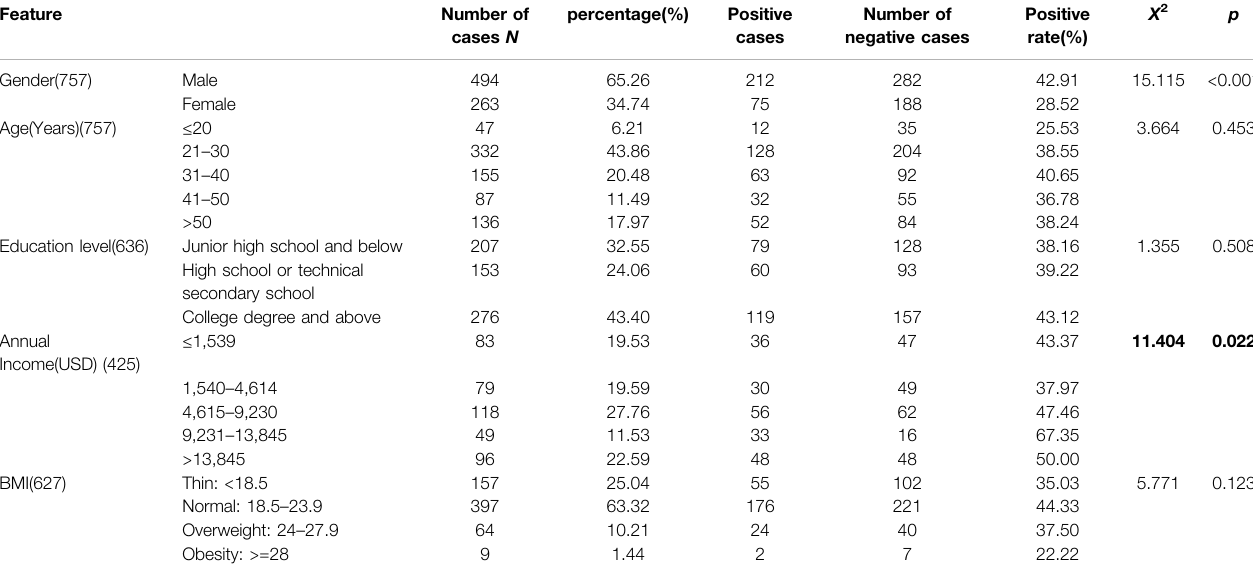
TABLE 2 | Demographic characteristics of TB patients and positive rate distribution.